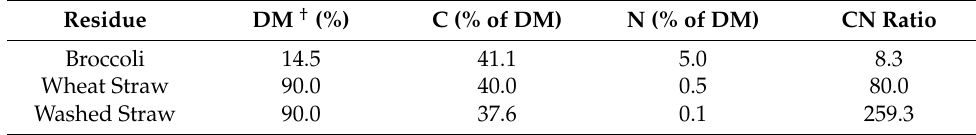
Table 3. Chemical constituents of crop residue used in this incubation study.